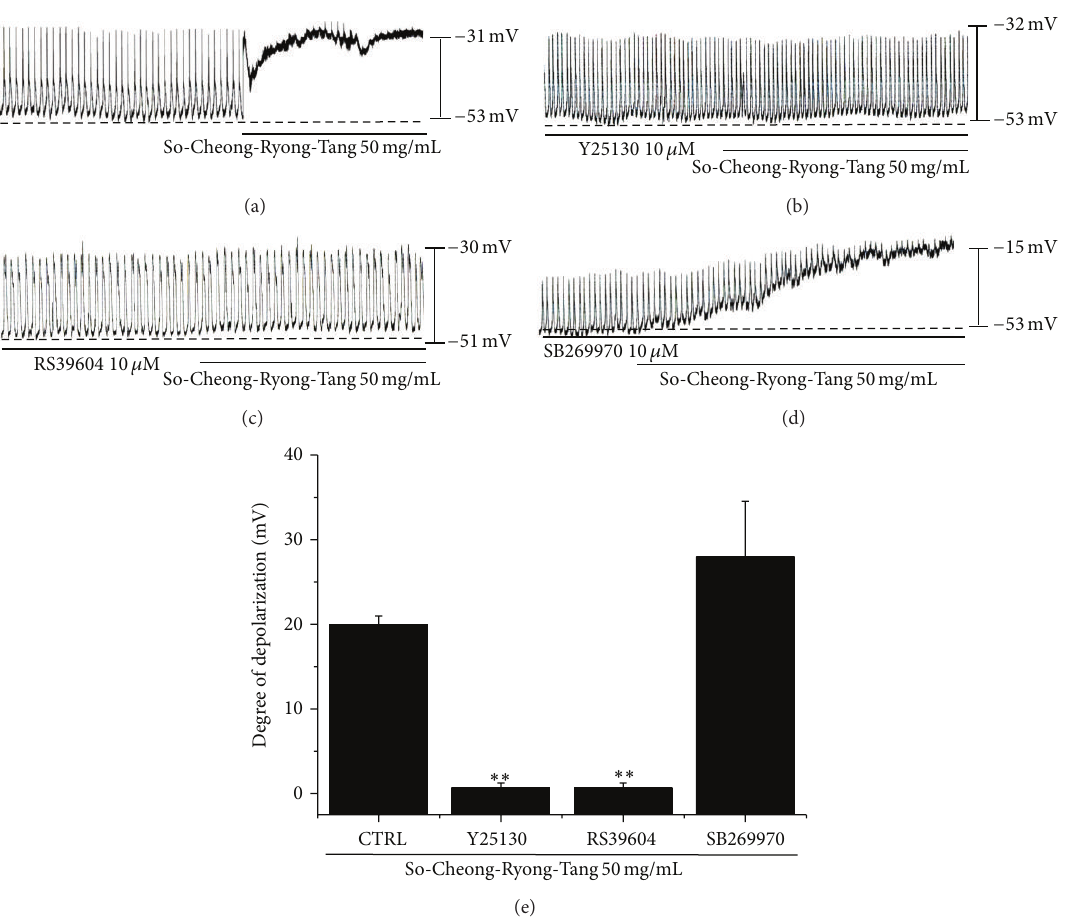
Figure 2: Effects of 5-HT receptor subtype antagonists on SCRT-induced pacemaker potential responses in cultured ICCs. (a) SCRT (50 mg/mL) induced membrane depolarizations on ICCs. (b) Pacemaker potentials of ICCs exposed to SCRT (50 mg/mL) in the presence of 5-HT 3 receptor antagonist (Y25130; 10 𝜇 M). (c) Pacemaker potentials of ICCs exposed to SCRT in the presence of 5-HT 4 receptor antagonist (RS39604; 10 𝜇 M). (d) Pacemaker potentials of ICCs exposed to SCRT in the presence of 5-HT 7 receptor antagonist SB269970 (10 𝜇 M). Responses to SCRT in presence of different receptor antagonists are summarized in (e). Bars represent mean values ± SEs. ∗∗ 𝑃 < 0.01 . Significantly different from untreated controls. CTRL: